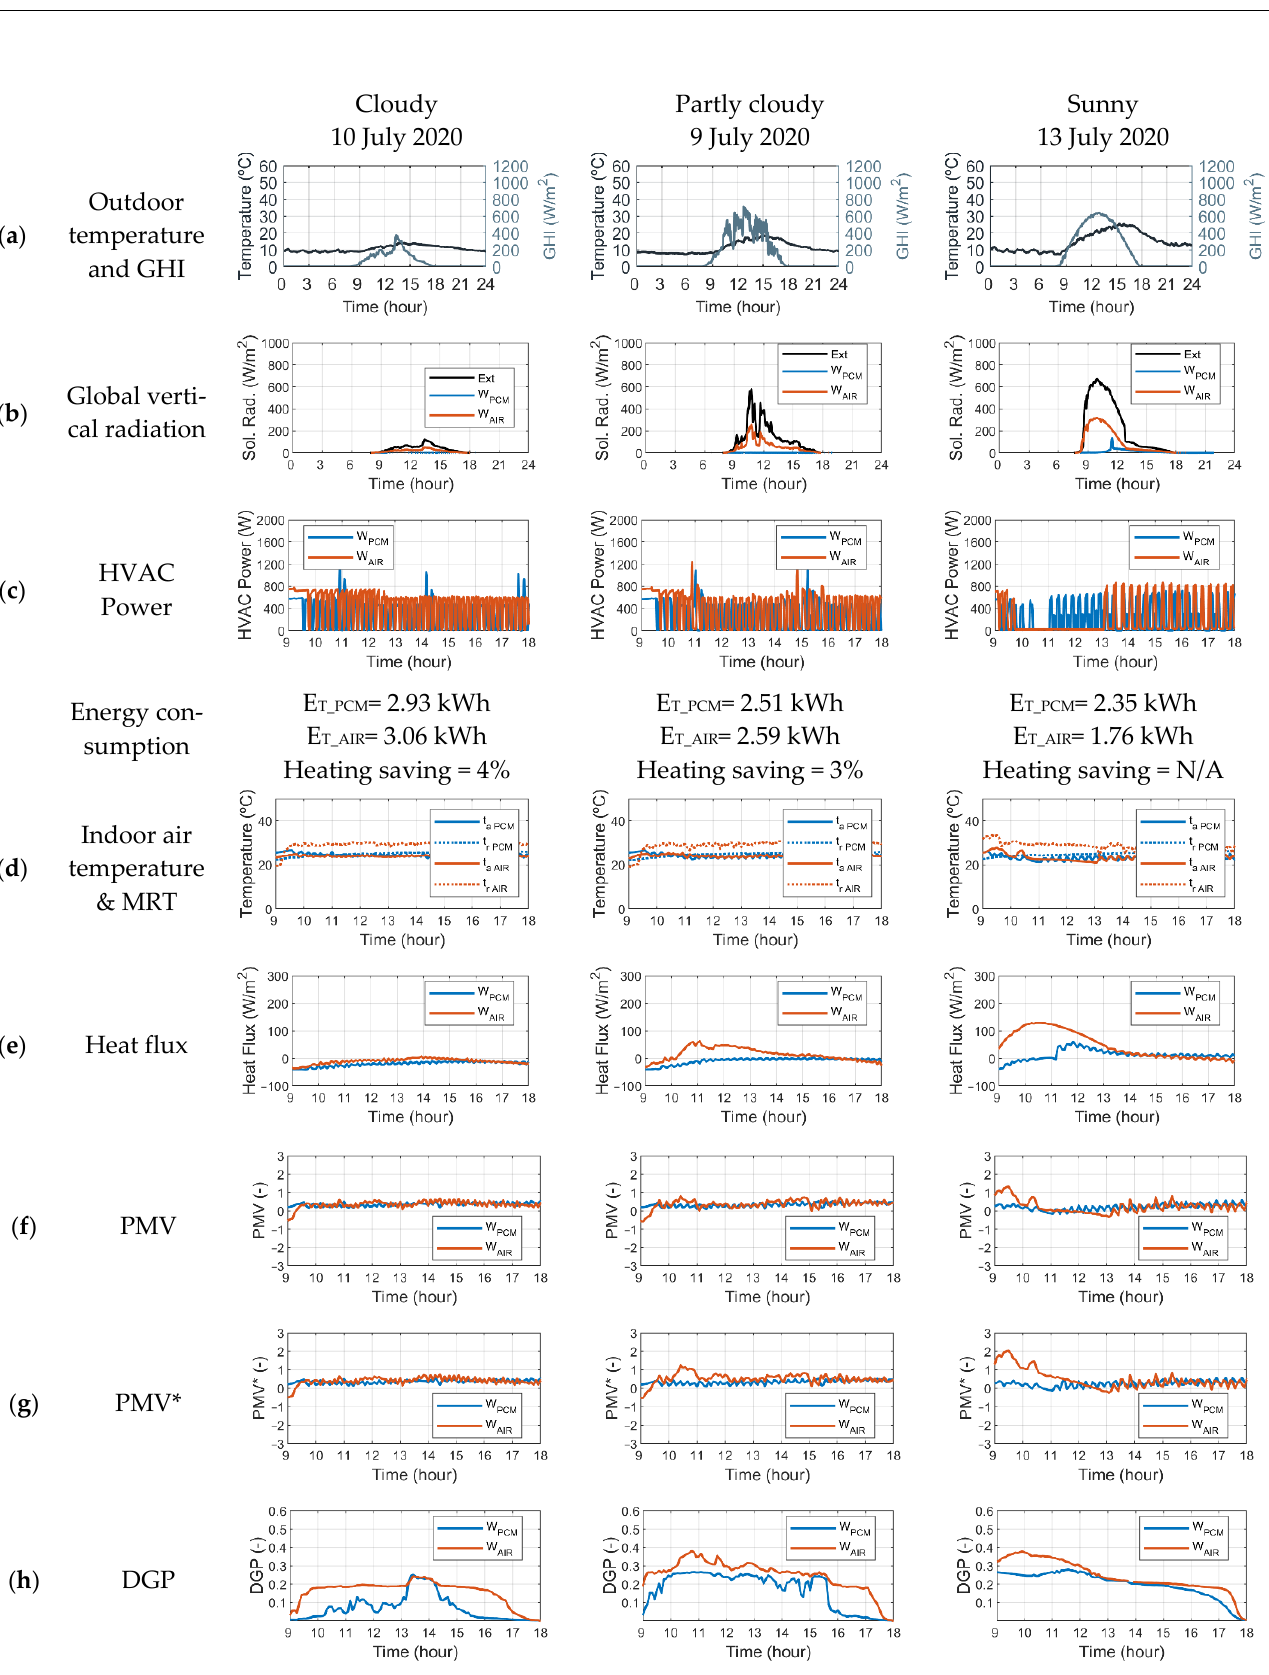
Figure 12. Results for representative days of winter. ( a ) Outdoor temperature and global horizontal radiation (GHI); ( b ) global vertical radiation; ( c ) HVAC power and energy consumption; ( d ) indoor air temperature & mean radiant Ttemperature (MRT); ( e ) heat flux; ( f ) PMV; ( g ) PMV*; ( h ) DGP.